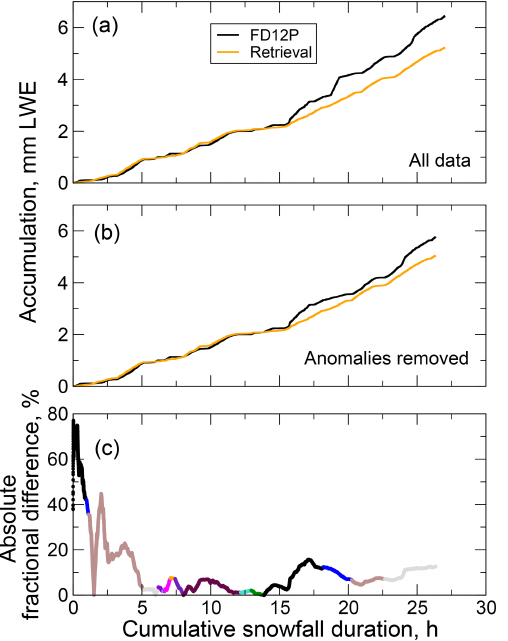
Figure 9. Snow accumulations computed from P ACR and P FD12P . The accumulations are for 17 snow events observed by the ACR on 18d between 3 November 2006 and 2 March 2007, but accumula- tions are principally from nine events (Table 1). The events were concatenated sequentially in time, and the time axis indicates the cumulative time over all events. (a) Accumulations from all obser- vations and corresponding retrieval results, (b) accumulations with two anomalous periods identified in Fig. 8 removed, and (c) frac- tional differences in accumulations shown in (b) , with distinct col- ors indicating individual events.